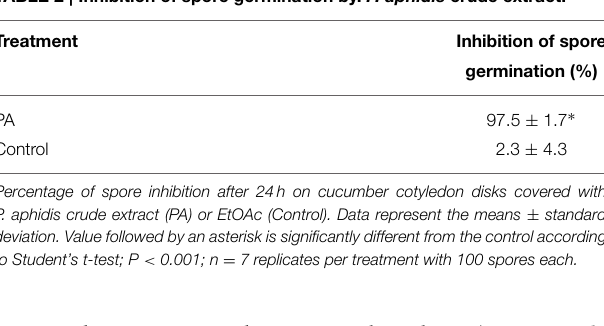
TABLE 2 | Inhibition of spore germination by. P. aphidis crude extract. Treatment Inhibition of spore